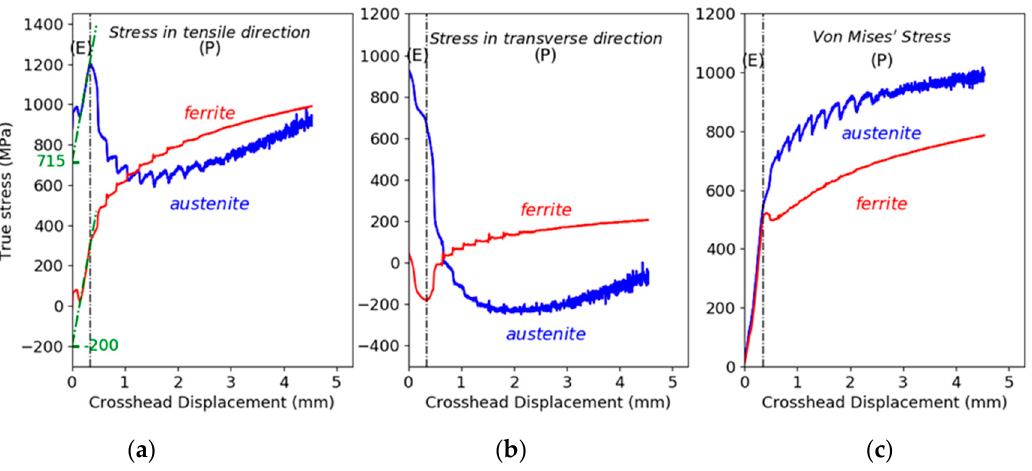
Figure 4. Stress in ferritic matrix (red) and retained austenite (blue) in the tensile direction ( a ), the transverse direction ( b ) and the von Mises stress ( c ) all along the experiment obtained through sin² ψ method. The measurement error on stress is 25 MPa. (determined on the Si calibrant).